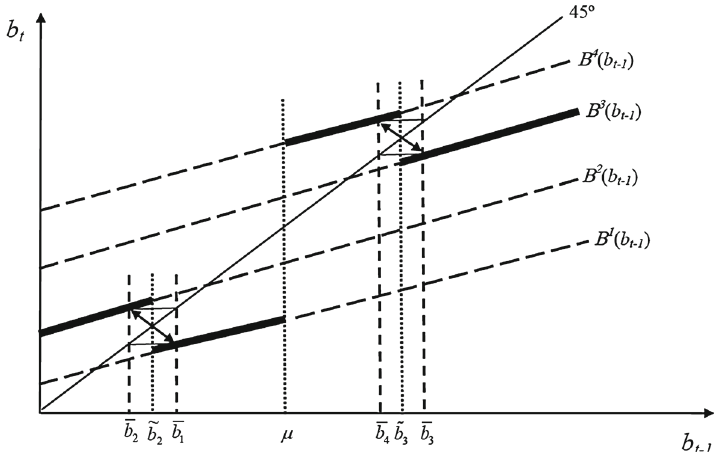
Fig. 7 Cycles in the amount of bequest for skilled and unskilled families. (Source: Alonso-Carrera et al.